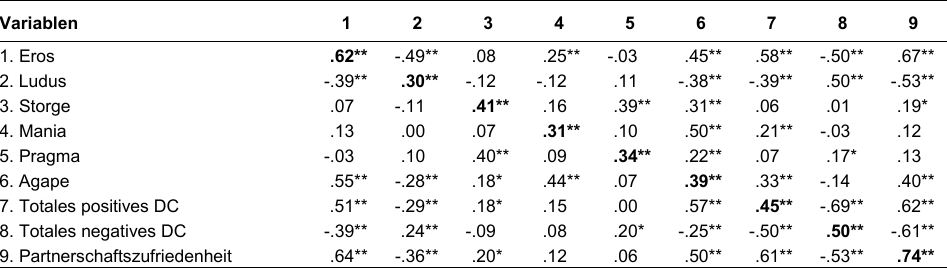
Tabelle 2: Korrelationen zwischen den Studienvariablen, für Frauen (über der Diagonale), für Männer (unter der Diagonale) und für die Dyade (in der